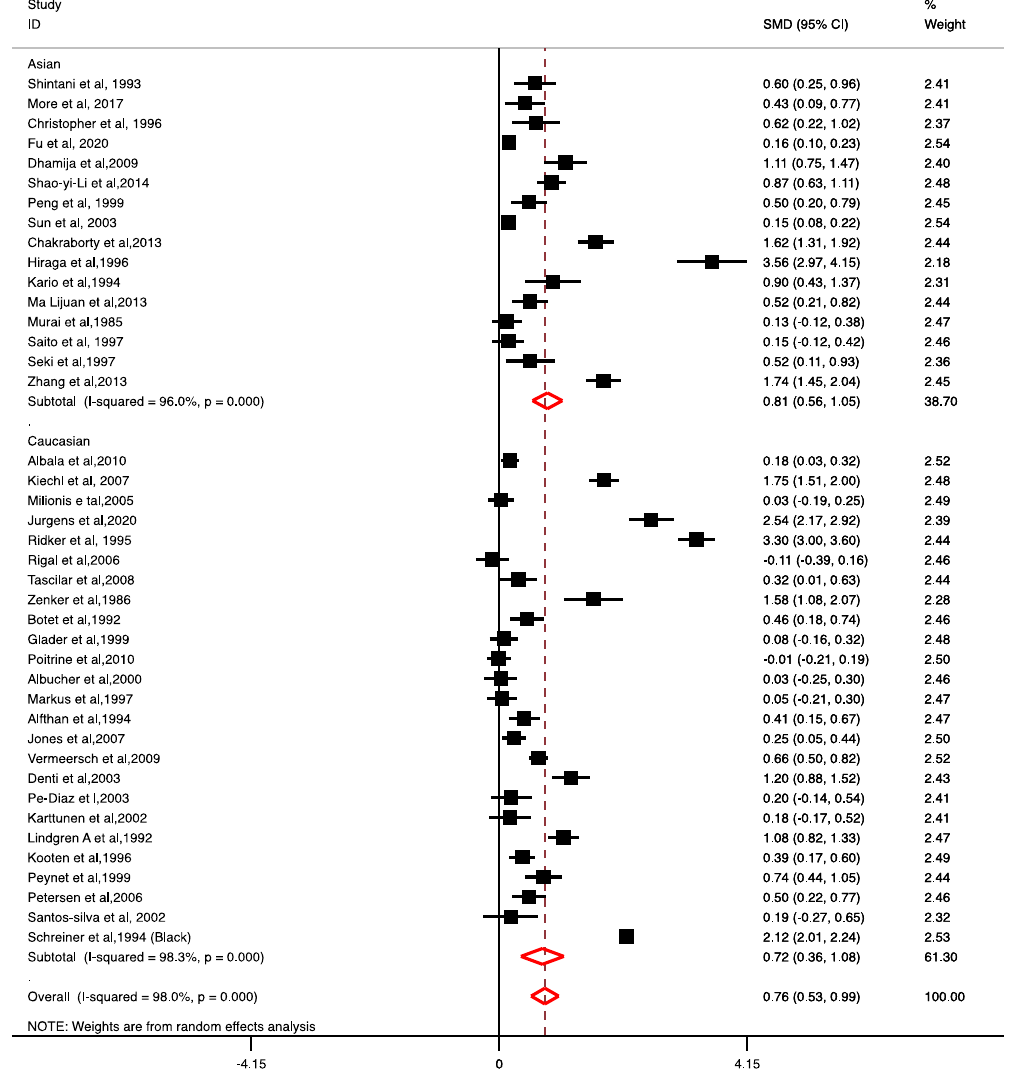
Figure 2. Forest plot for the association of Lp (a) level with the risk of Ischemic stroke vs. control based on